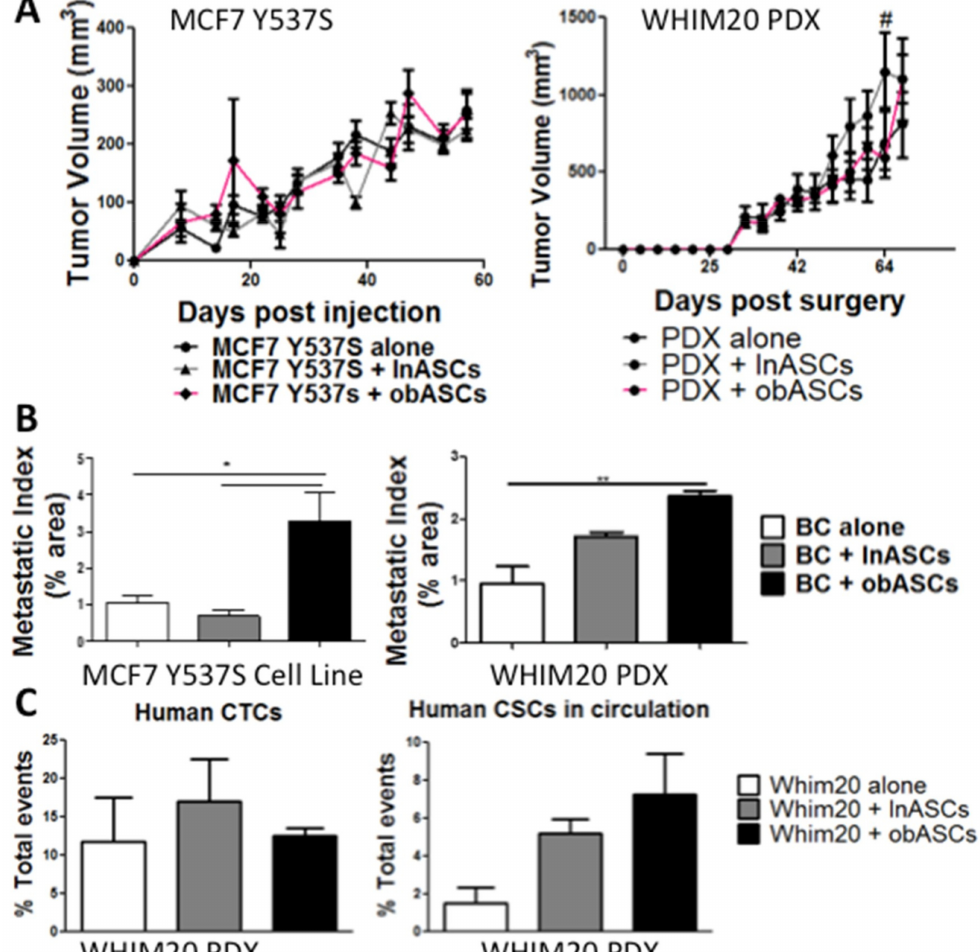
Figure 1. obASCs promote metastasis but not tumor growth of constitutively active ER α